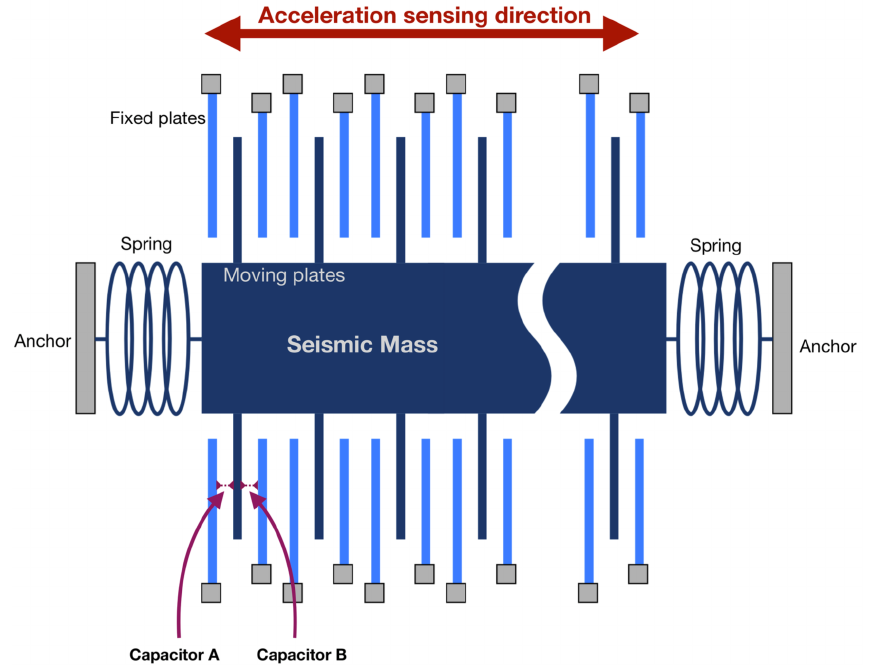
Figure 1. Working principle of a capacitive